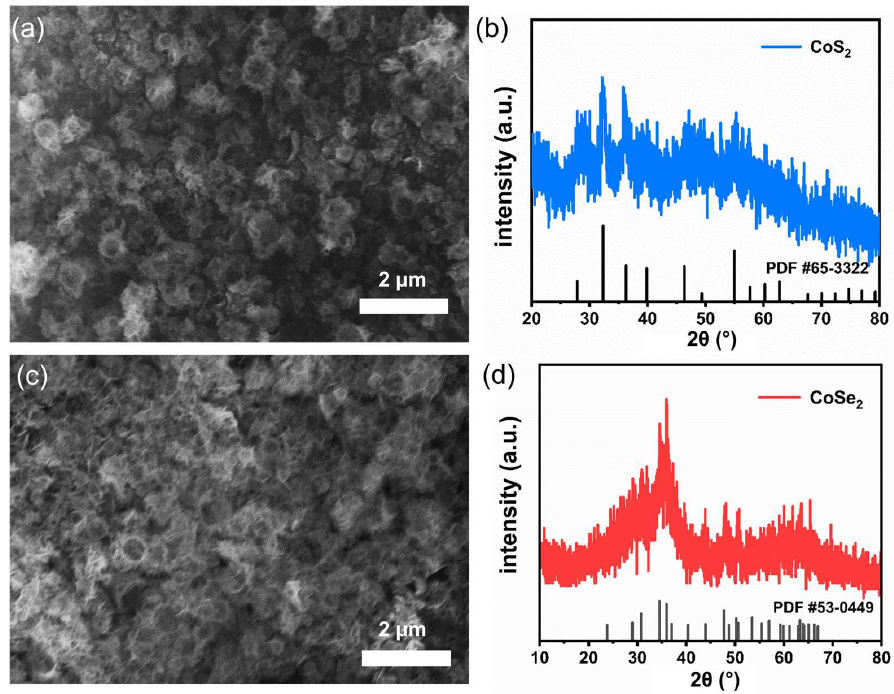
Figure 3. The SEM images of ( a ) CoS 2 and ( c ) CoSe 2 ; the XRD patterns of ( b ) CoS 2 and ( d ) CoSe 2 .